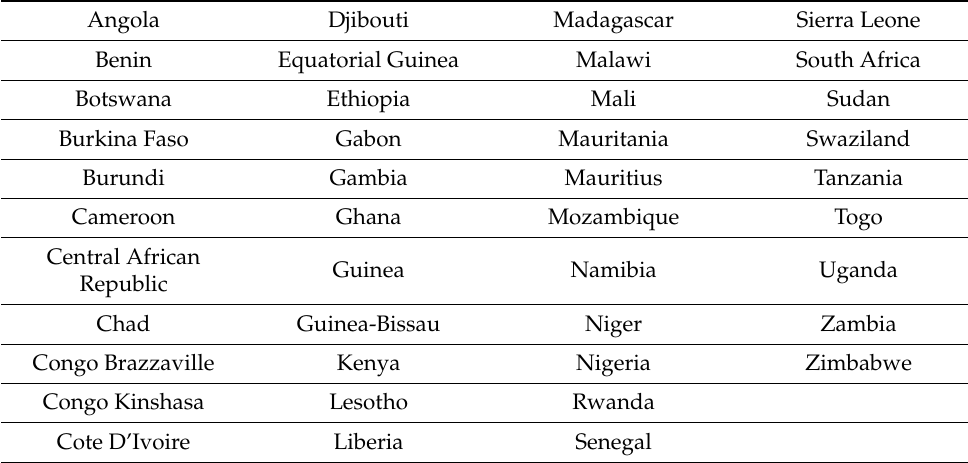
Table A6. Sub-Saharan Africa—42 Countries.